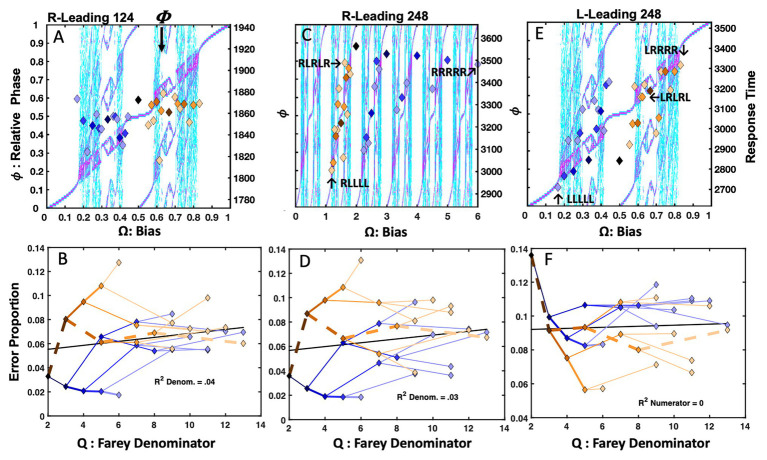
Plot (A) depicts the 1-2-4 letter rotation trial histories as a function of bias and relative phase. The repetition and golden ratio trial histories were faster than the remaining sequences. Plot (B) depicts the error Farey tree for the 1-2-4 condition. It retained consistent branching, despite the manipulation’s impact on the relative speed of R and L responses. Plot (C) depicts the R-leading 2-4-8 letter rotation trial histories, in terms of the L-leading ratios and bifurcation diagram. Increasing the duration of “yes” responses slowed the R-leading ratios, and they expressed the relative phases typical of the L-leading ratios. Plot (D) indicates the error branching remained consistent with the stability of the R-leading ratios. Plot (E) depicts the L-leading ratios for the 2-4-8 task. The speeded “no” responses conformed to the staircase, as predicted by their new role as the relatively faster oscillator. In Plot (F) the color-coded Farey branching for the L-leading ratios is inverted in a manner consistent with the L-leading portion of the Stern-Brocot tree. The LRRRR pattern, and the related brown and tan branches are the least error prone. The LLLLL pattern has lower errors, relative to related branches, indicating stability. Likewise, the bulk of the blue branches now fall above the regression line.